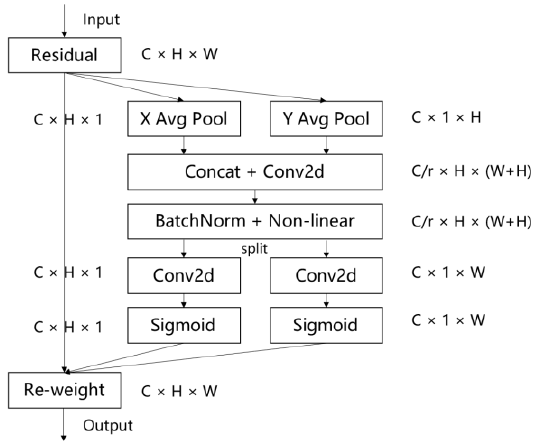
Figure 3. The coordinate attention mechanism.